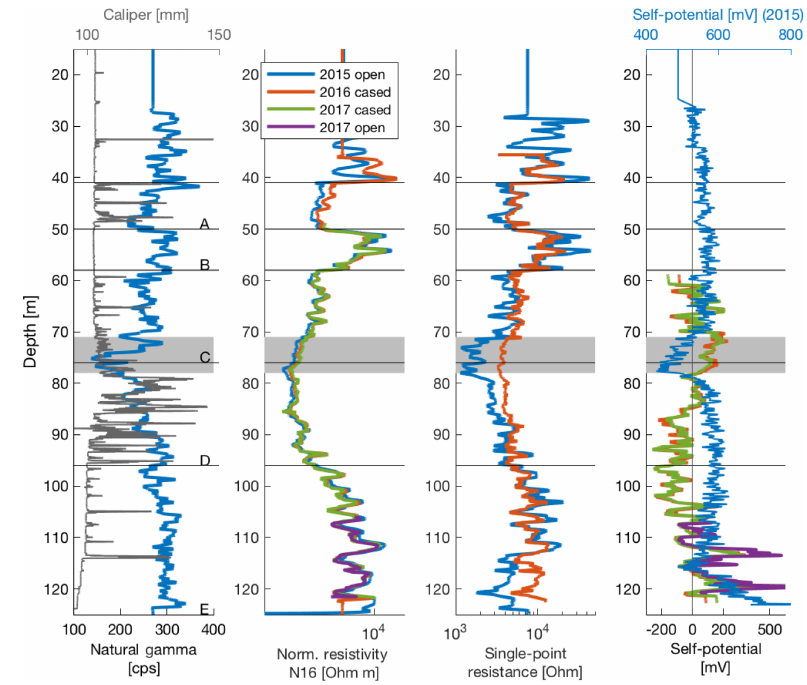
Figure B2. Comparison of open-hole and casing-corrected